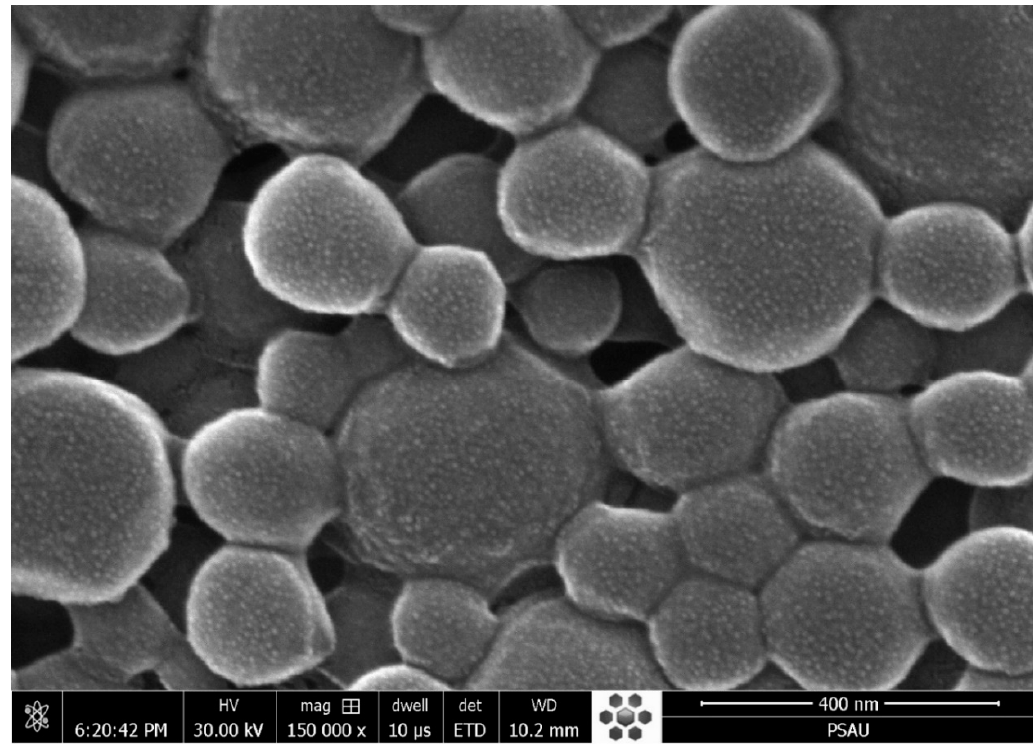
Figure 5. SEM images of optimized ELX loaded SLNs (F2).